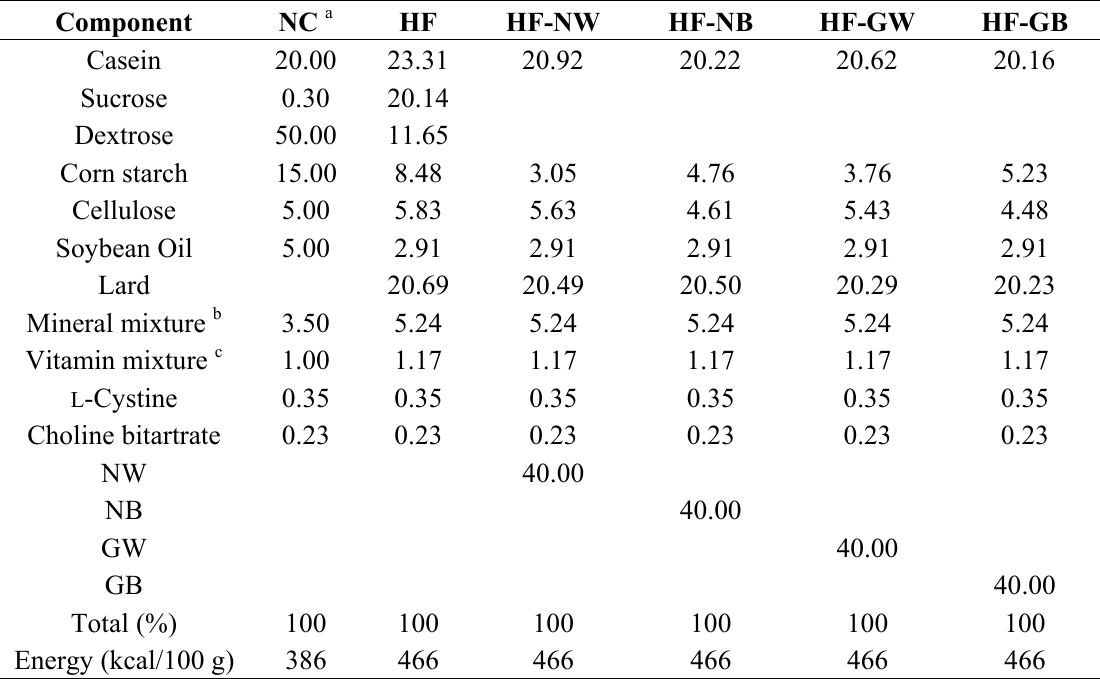
Table 2. Composition of experimental diets